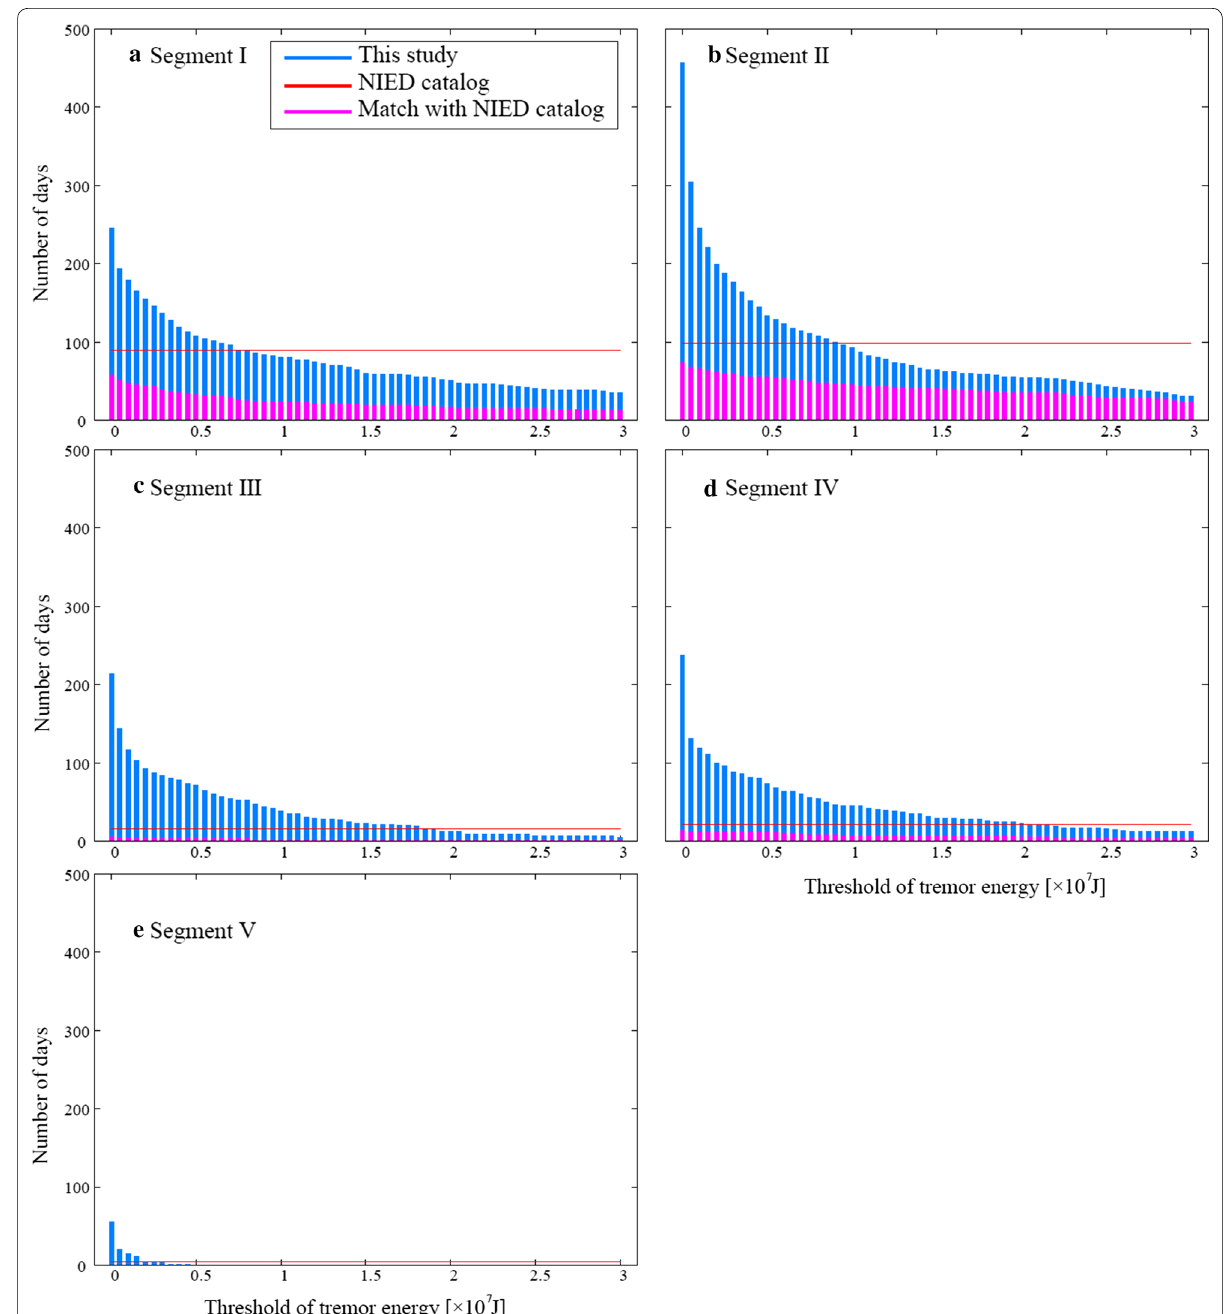
Fig. 4 Comparison of the duration and timing of SSEs in our study with those in the NIED catalog in each segment. Blue vertical bars show the number of days categorized into the release period when the tremor energy threshold is changed. Pink vertical bars show the number of days in which the SSE periods in this study correspond to those in the NIED catalog. Red horizontal lines show the total durations of SSEs in the NIED catalog. a Comparison in segment I. b Same as a , but in segment II. c Same as a , but in segment III. d Same as a , but in segment IV. e Same as a , but in segment